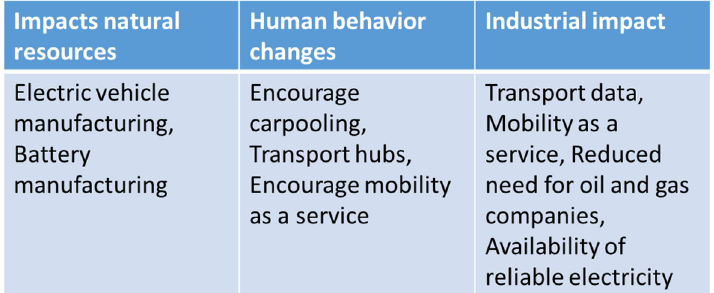
Figure 5. Roadblocks for 100% EV adoption.